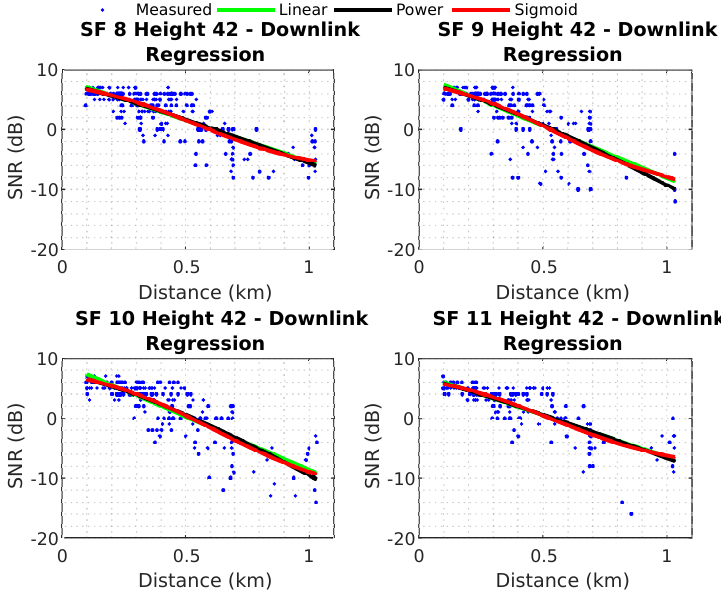
Figure 12. Baseline models downlink.